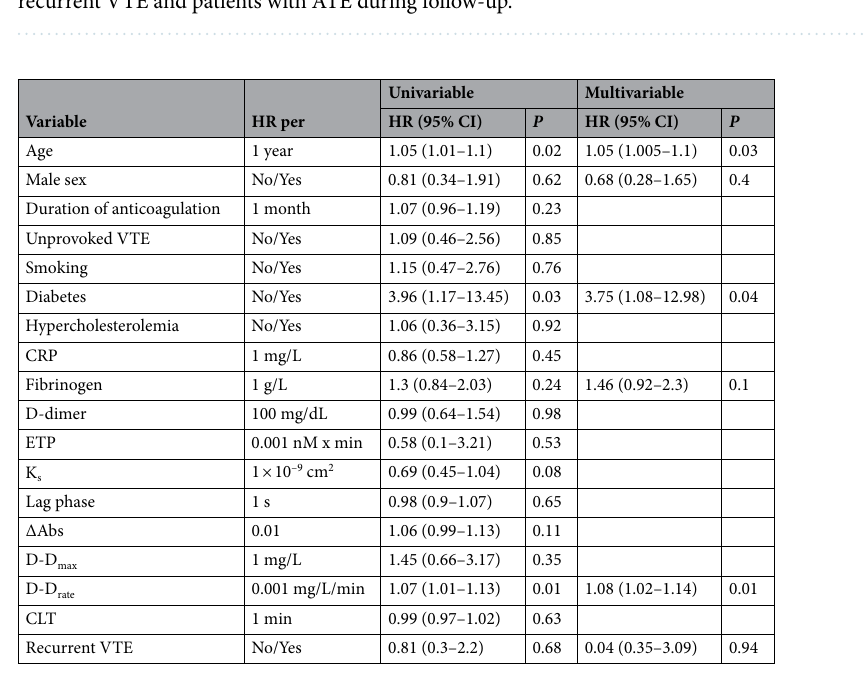
Table 3. The univariable and multivariable Cox proportional hazards models for risk factors of ATE. HR hazard ratio, CI confidence interval, CRP C-reactive protein, ETP endogenous thrombin potential, for other abbreviations see Tables 1 and Table 2. In terms of ATE two patients excluded from the previous analysis were included in the current follow-up study. Twenty-one patients with ATE and 289 patients without ATE were included in the Cox proportional hazards models. Age, gender, diabetes, fibrinogen, D-D rate and recurrent VTE were included in the multivariable model. C-statistic =